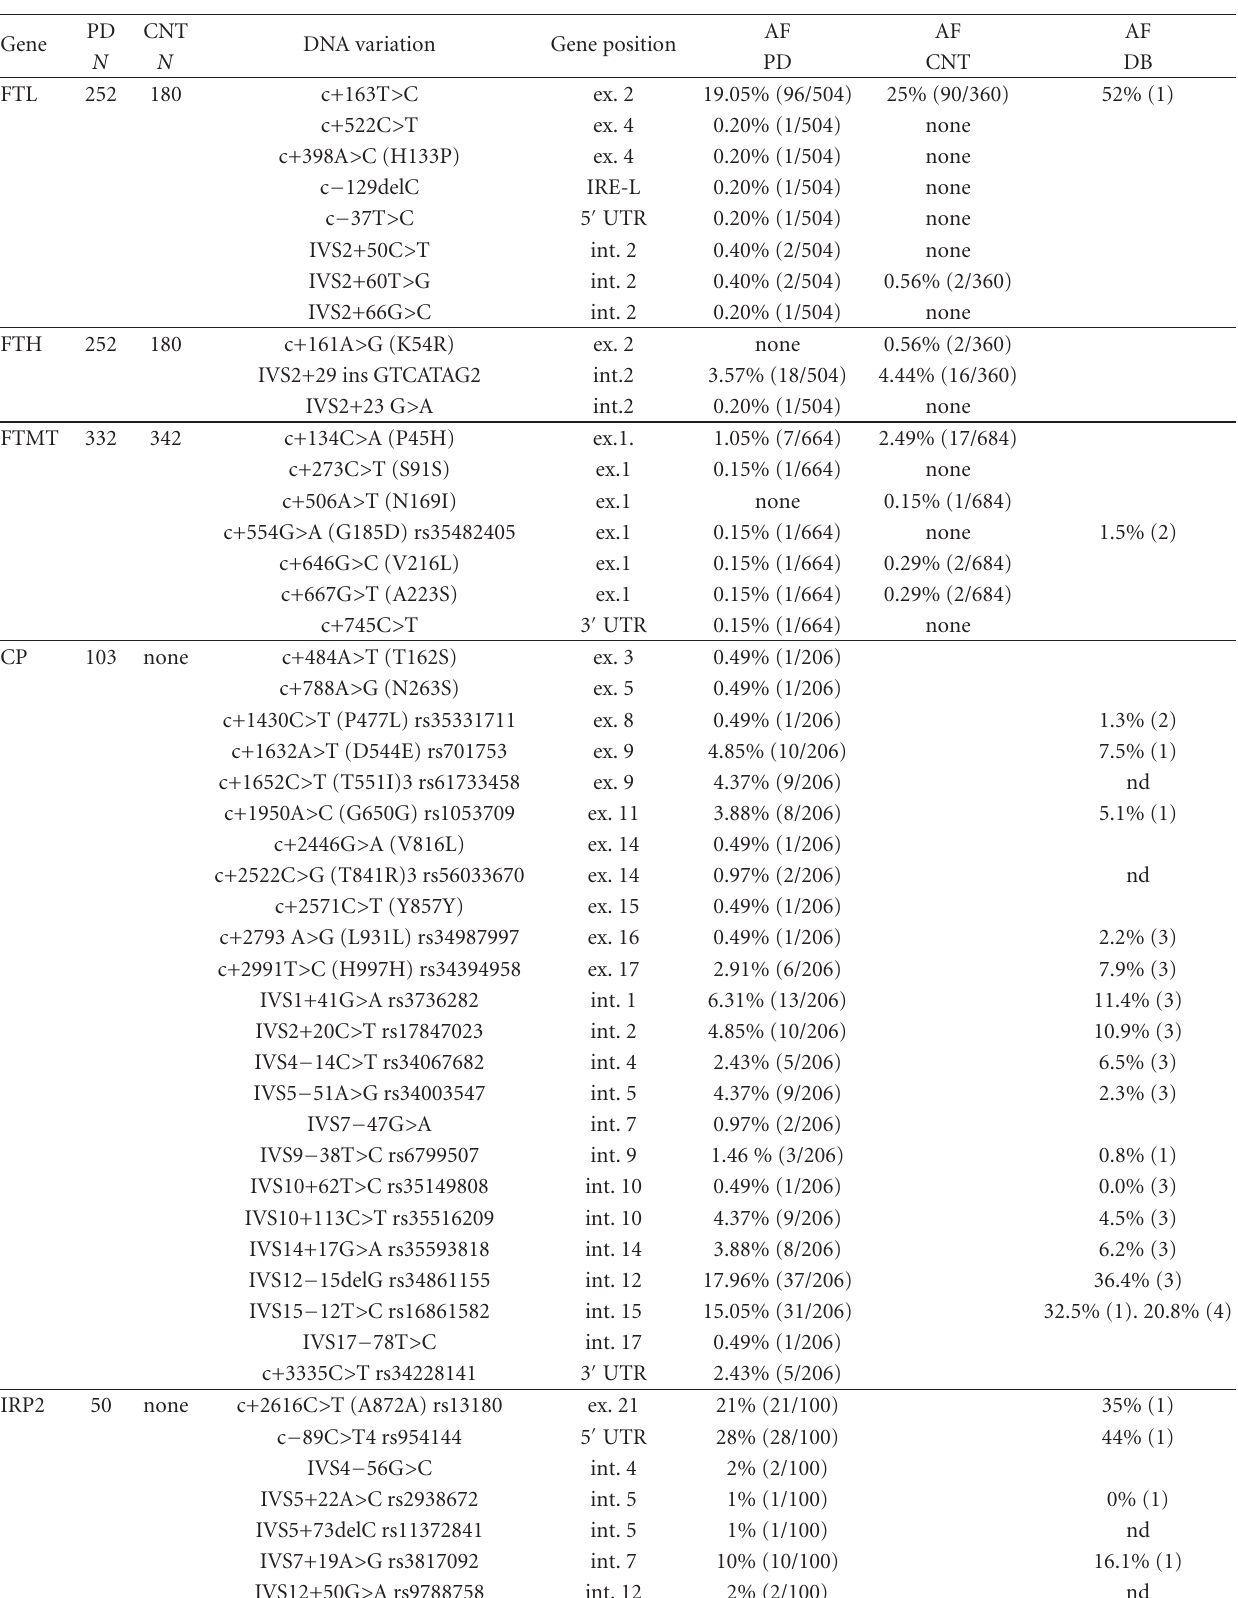
Table 1: Allelic frequencies of the sequence variations identified in FTL, FTH, FTMT, CP, IRP2, HPX, and HAMP genes in PD patients and